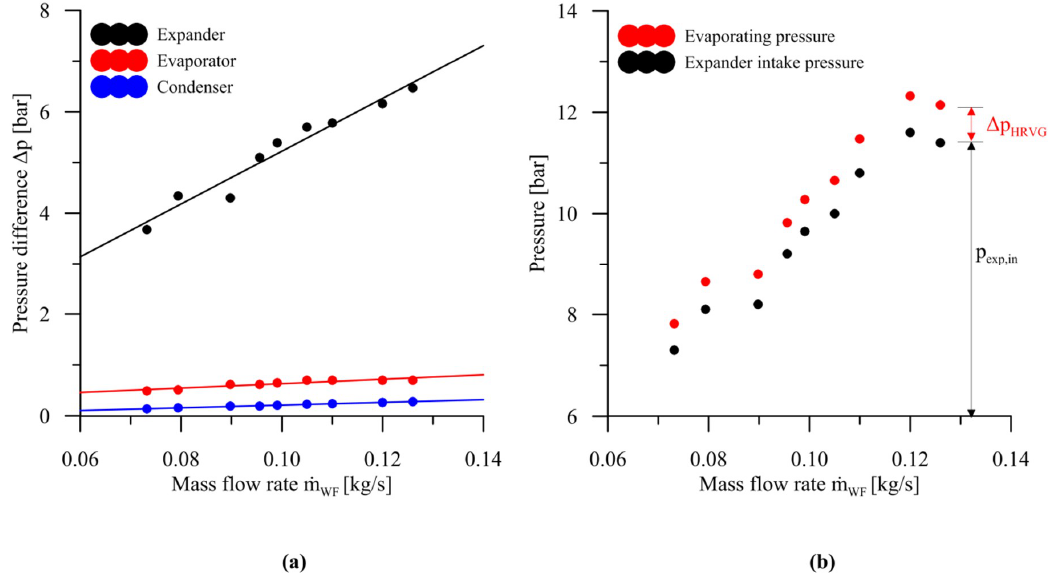
Figure 4. ( a ) Pressure drop across the evaporator, condenser, and expander varying the mass flow rate; and ( b ) evaporating and expander intake pressure varying the mass flow rate provided by the pump.